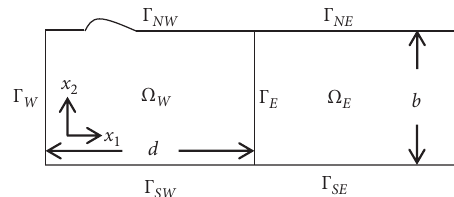
2: The illustration of domain Ω W and Ω E